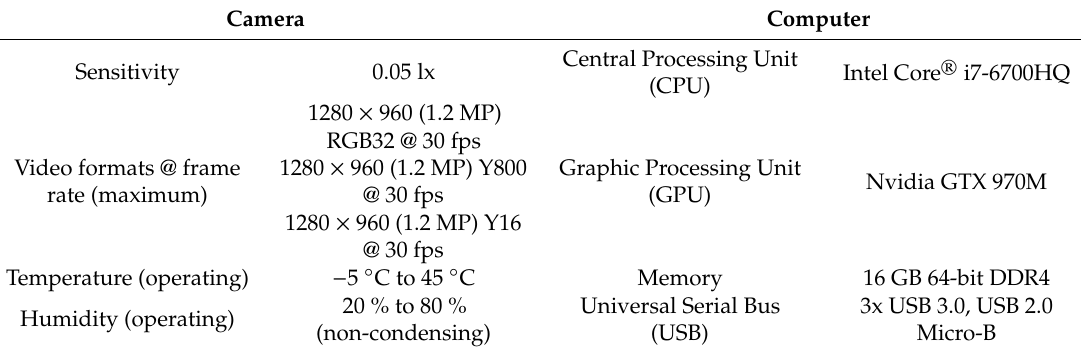
Table 1. Specifications of the camera and the processing